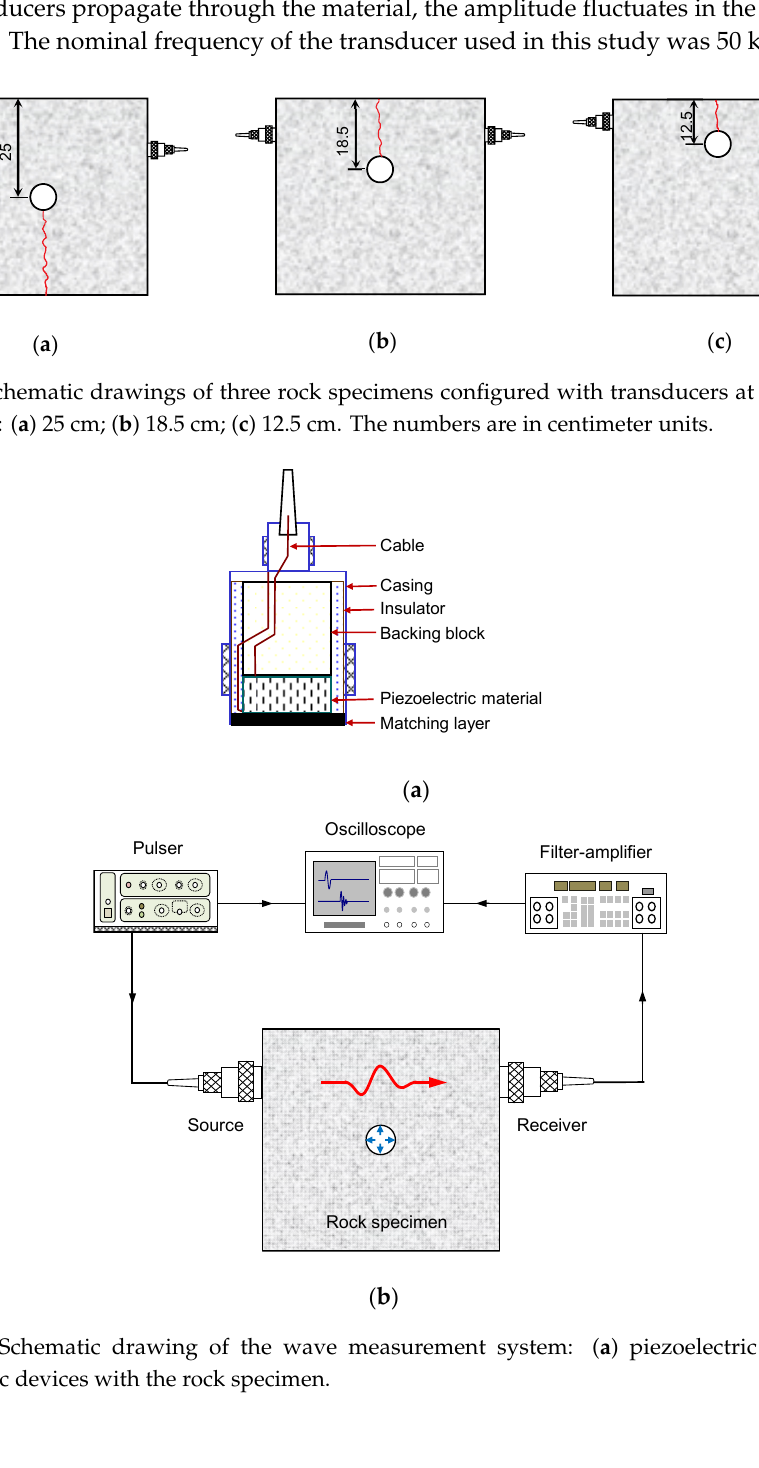
Figure 6. Schematic drawings of three rock specimens configured with transducers at hole-to-face distances of: ( a ) 25 cm; ( b ) 18.5 cm; ( c ) 12.5 cm. The numbers are in centimeter units.